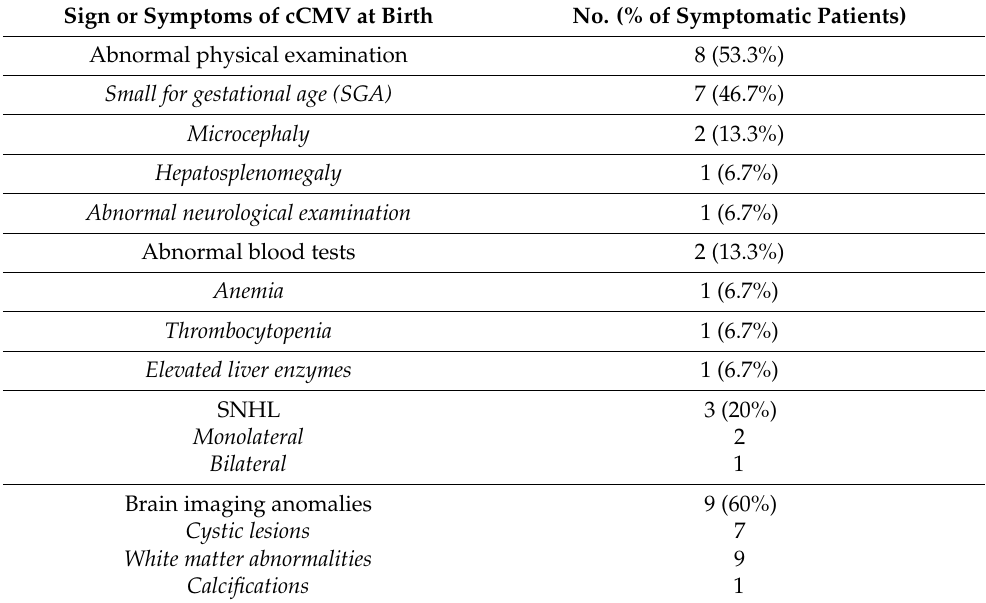
Table 1. Clinical manifestations in 15 children with symptomatic cCMV infection at birth. Sign or Symptoms of cCMV at